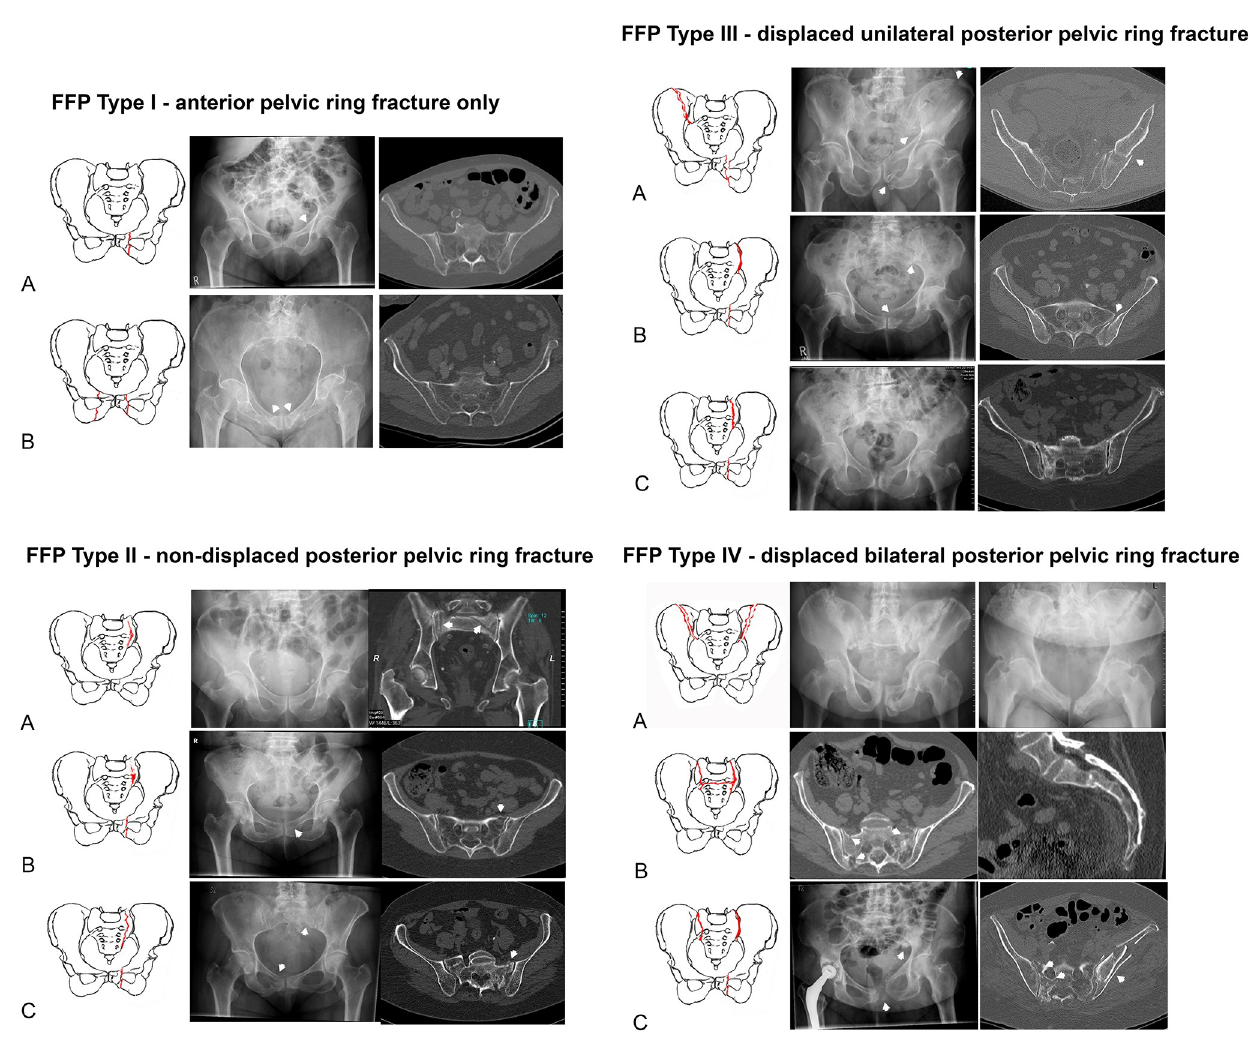
Fig 1. FFP-classification with categories and subcategories